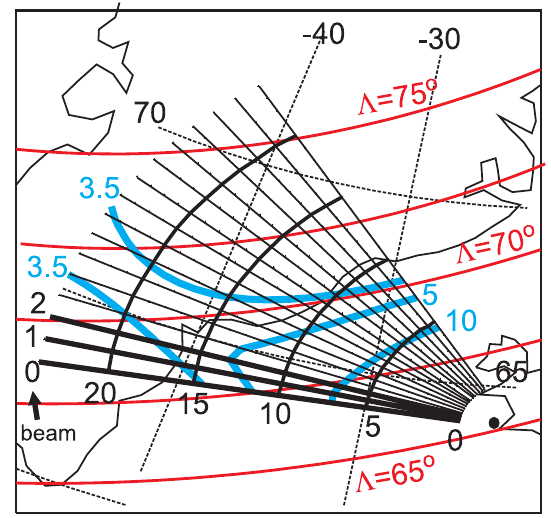
Fig. 2. The field-of-view of the Stokkseyri SuperDARN radar be- tween gates 0 and 24 (ranges 180–1260km). The height of 110km is assumed. The blue lines are the zero aspect angle lines for obser- vations under various electron densities in the ionosphere (densities are also shown in blue in units of 10 10 m − 3 ) at 110km and the radar frequency of 12MHz. The thick lines are the AACGM magnetic latitudes of 65 ◦ –75 ◦